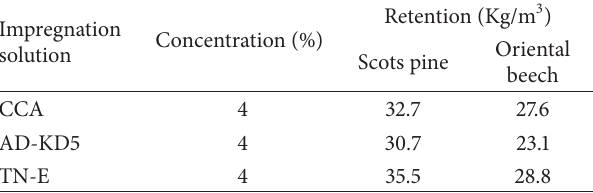
Table 2: Retentions of wood